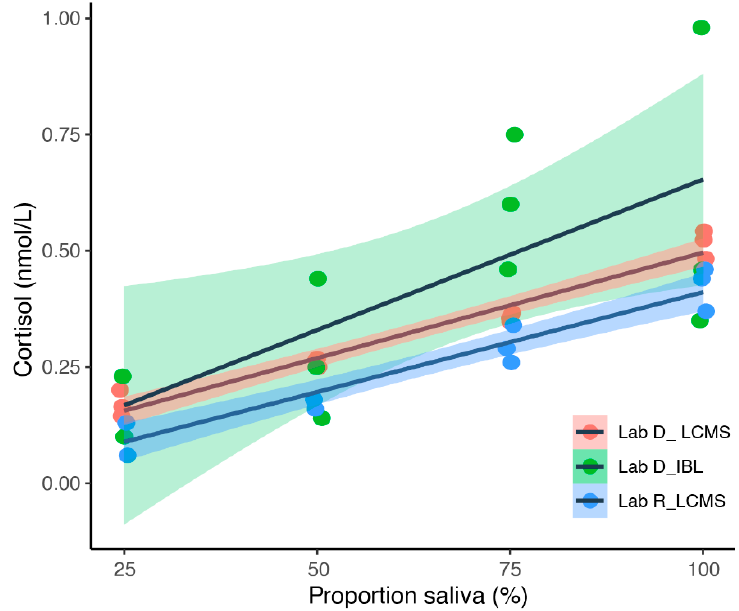
Figure 2. Dilution series for saliva cortisol analyzed at two laboratories (Lab R and Lab D). Saliva was collected over some days, accumulated, and then diluted with different proportions of 0.9% NaCl solution. Saliva samples were analyzed with two different methods LC ‐ MS/MS (LC ‐ MS) and immunoassays (IBL).